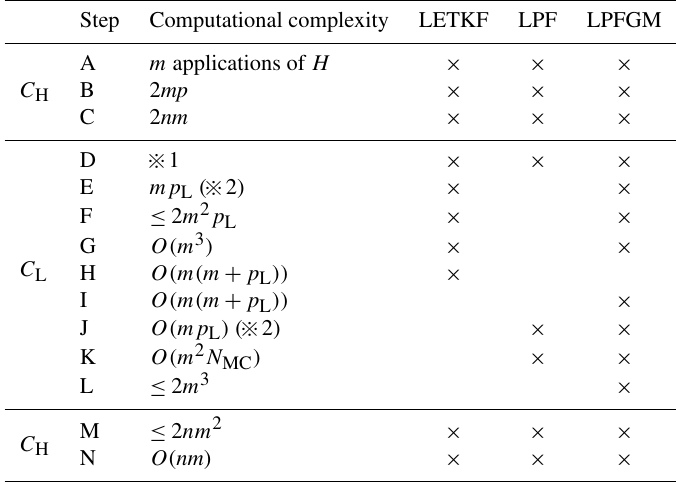
Table 1. Computational complexities of LETKF, LPF, and LPFGM. Each step corresponds to the steps in Fig. 3. Cross marks represent the steps used for LETKF, LPF, and LPFGM. Step Computational